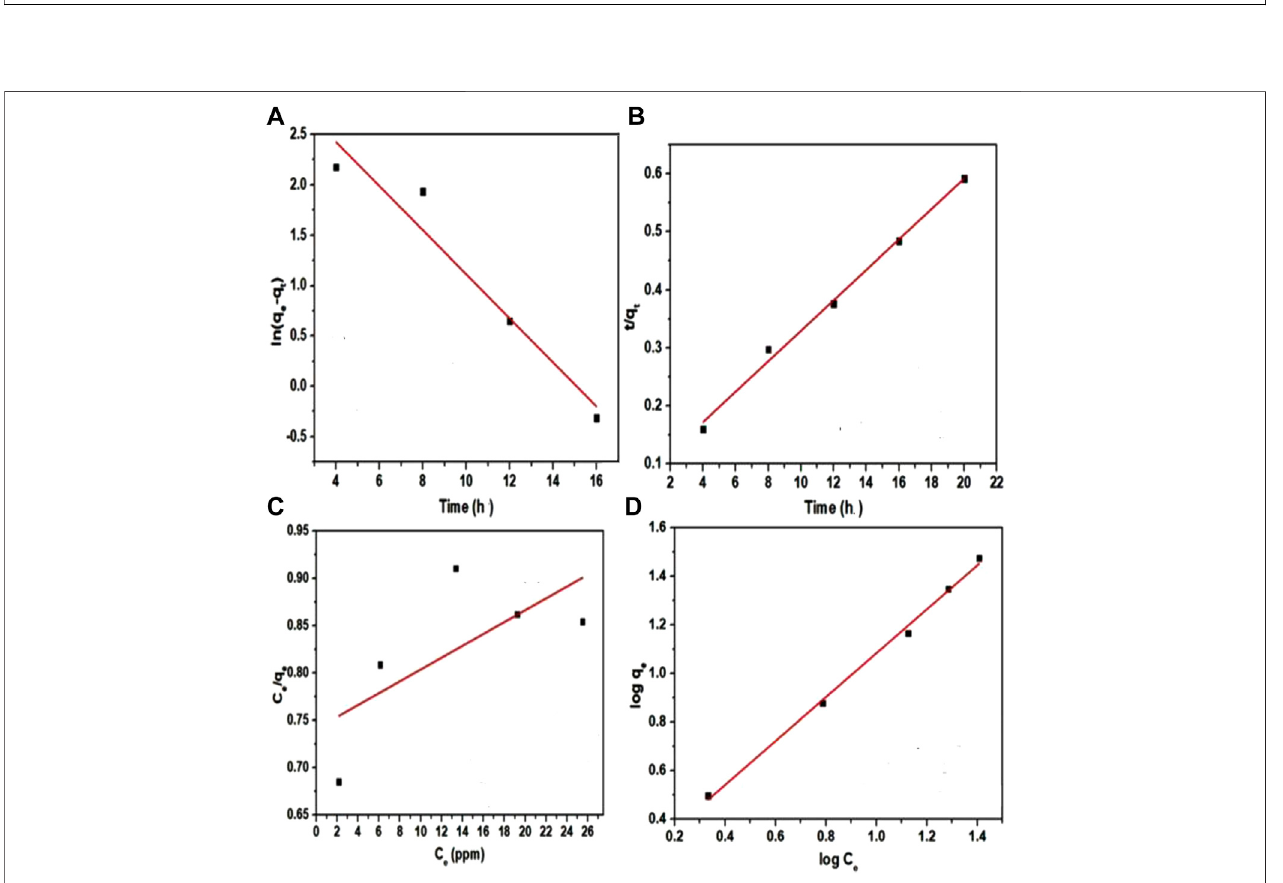
FIGURE 9 | (A-D) (A) Pseudo fi rst order kinetics; (B) Pseudo second order kinetics; (C) Langmuir adsorption isotherm and (D) Freundlich adsorption isotherm.